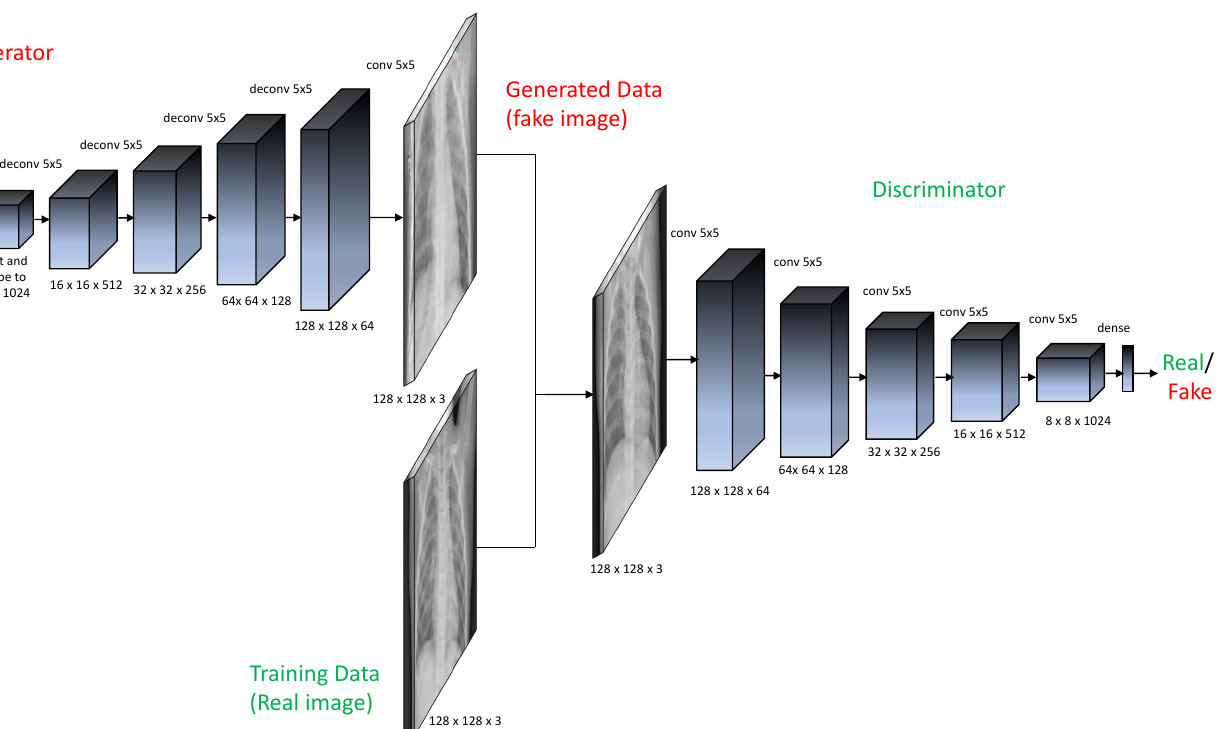
Figure 2. Deep Convolutional Generative Adversarial Network